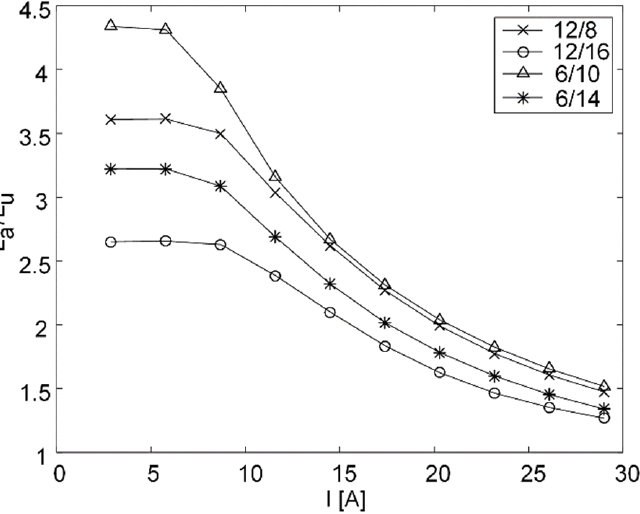
Figure 14. Aligned to unaligned inductance ratio for different SRM configurations and at differ- ent currents.